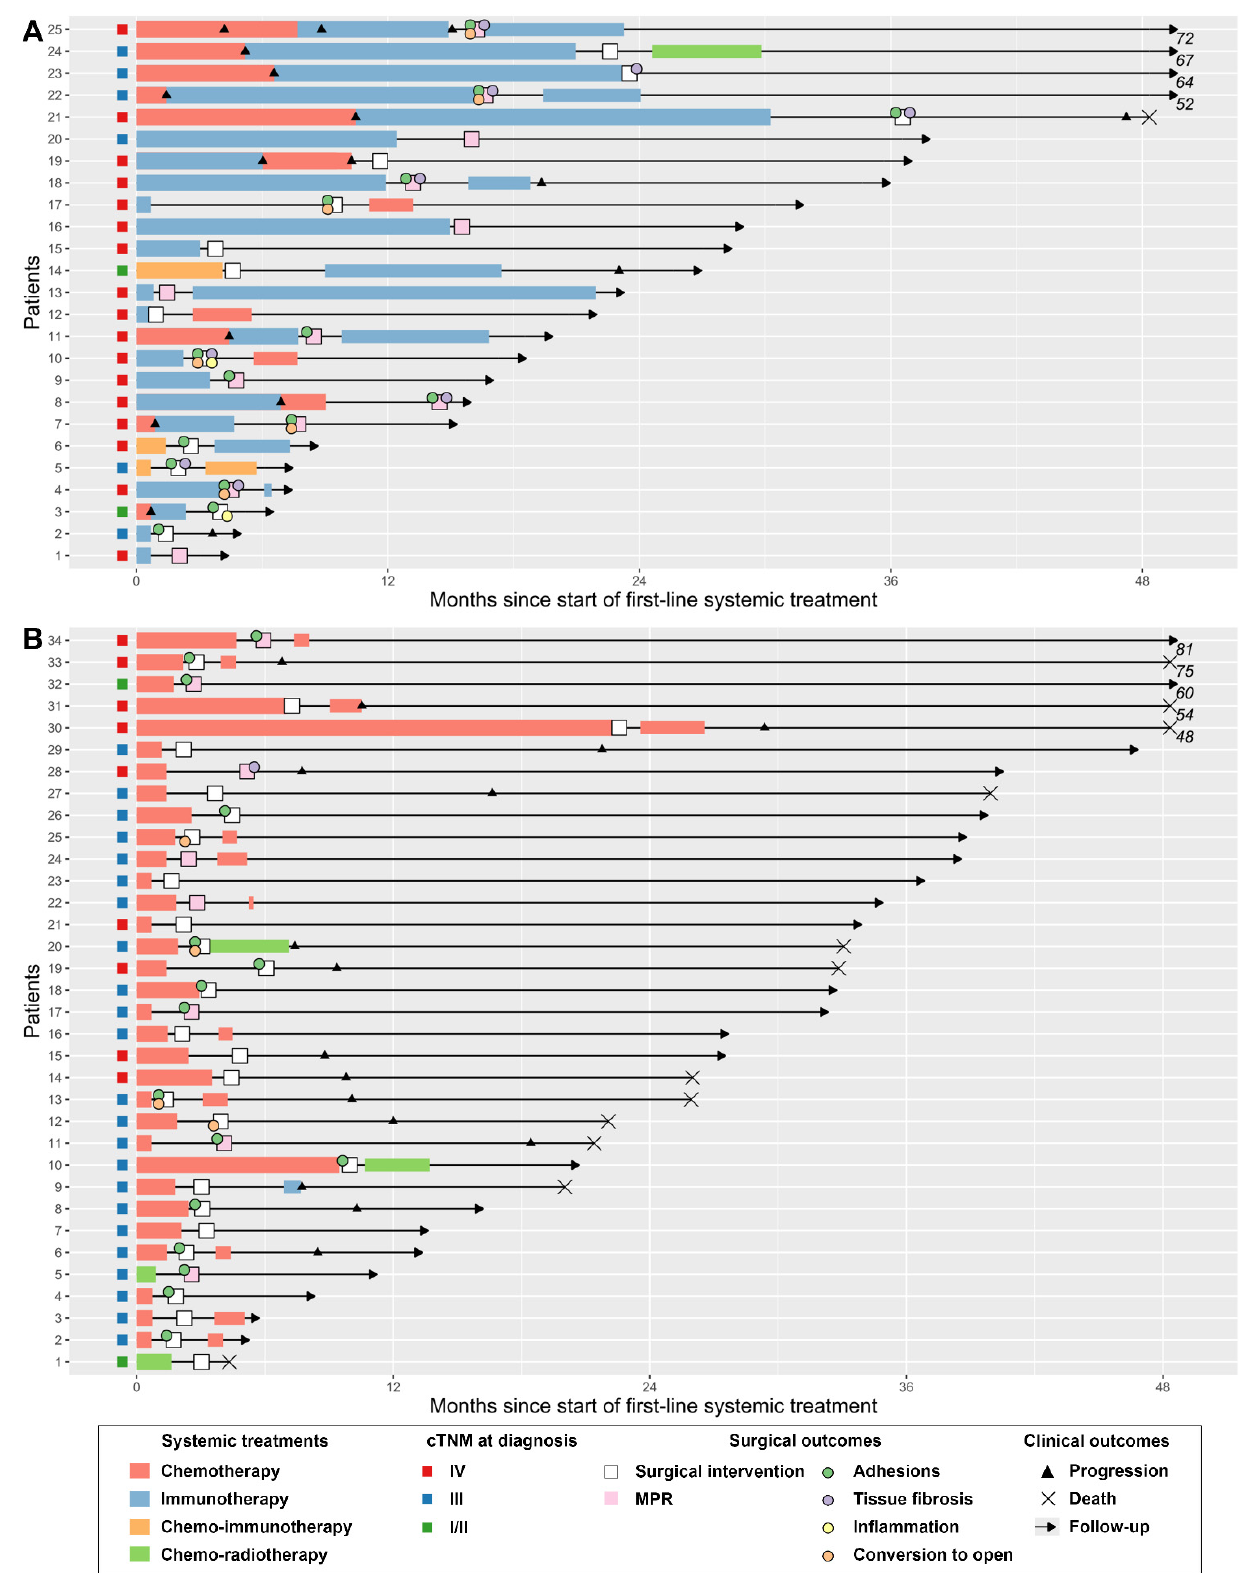
Figure 7. Swimmer plot showing duration of follow-up; systemic treatments administered; and surgical, clinical, and pathological outcomes. ( A ) Immune checkpoint inhibitors group (n = 25). ( B ) Control group (n = 34). Systemic treatments and clinical progressions were recorded exhaustively prior to surgery. Following surgery, first-line adjuvant treatment, date of first progression, and last follow-up were collected. Abbreviations: MPR: major pathological response.